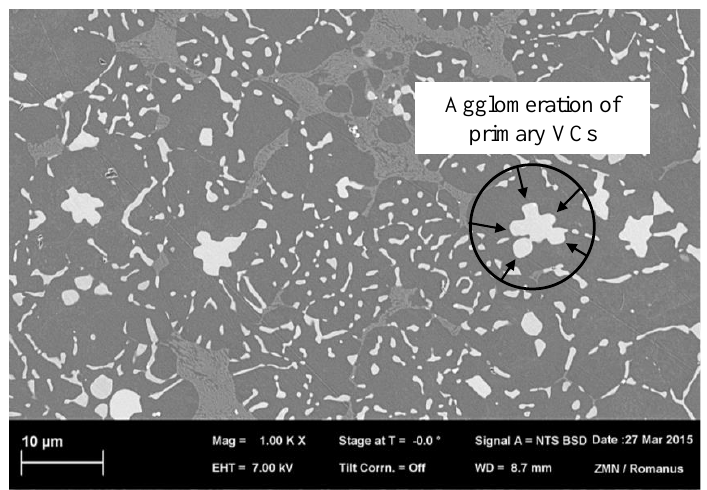
Figure 9. Agglomeration of primary VCs during hot wire assisted gas metal arc welding (HW-GMAW).